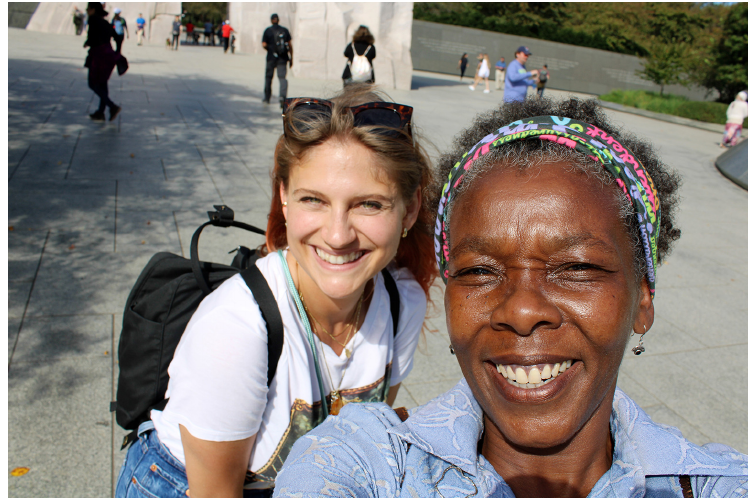
Figure 9. Denaise Seals and I at the MLK Memorial, in 2021. Note: Used with permission. Media and Communication, 2022, Volume 10, Issue 3, Pages